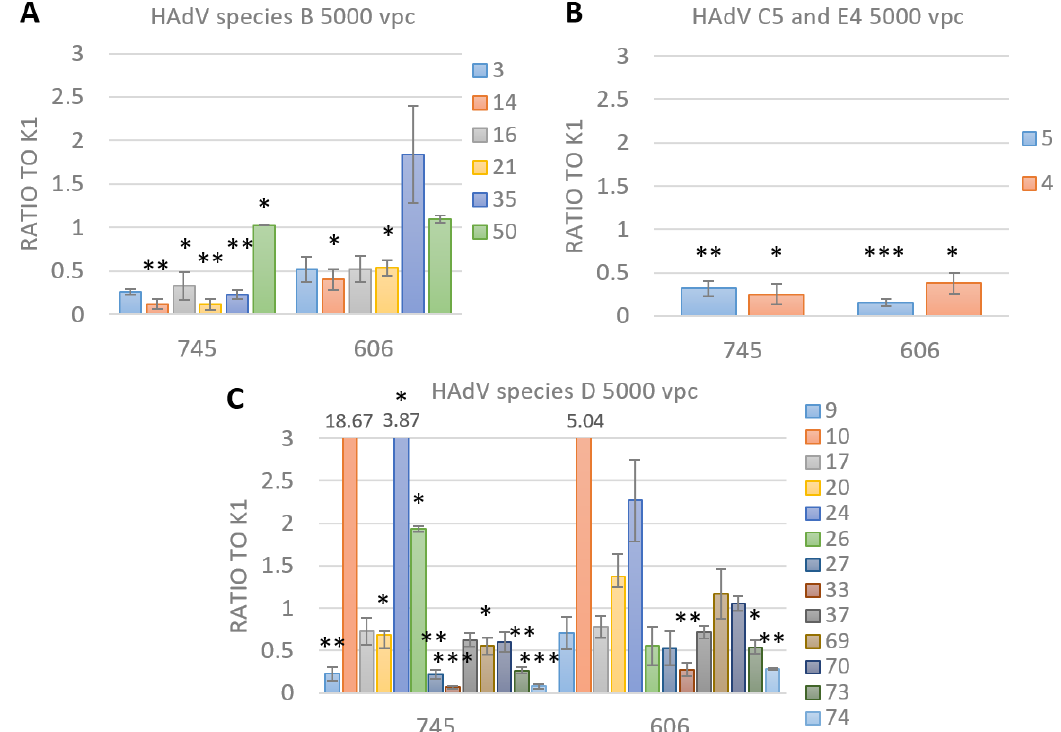
Figure 3. GLN-tagged adenovirus library screening in HSPG-depleted CHO cell lines. 24 h post-infection with 5,000 vpc luminescence was measured. All RLU (relative light units) from sulfation-ablated CHO-606 and heparan chain-ablated CHO-745 cells were normalized to the CHO-K1 cells with the wild type version of HSPG. For each Ad type, the fold increase compared to results obtained in CHO-K1 cells is displayed. A. Species B Ads show lower or similar transduction efficiency in CHO-606 and -745 cells compared with CHO-K1 cells. B. Species C and E Ads show a significant decrease in transduction efficiency compared to the wild type form of HSPG. C. For species D Ads 10 out of 13 showed a decrease in transduction efficiency in CHO-606 and -745 cells compared to CHO-K1. Mean ± SEM (standard error of the mean) of n=3 biological replicates is shown. * p ≤ 0.05, ** p ≤ 0.01, *** p ≤ 0.001. Table 2. Summary of the results from the adenovirus screening in HSPG-depleted CHO cell lines. In green are Ad types with the highest uptake detected by luciferase assay in CHO-K1 cells, in blue are Ad types with the highest uptake in -606 and in orange are Ad types with the highest uptake in -745 cells are marked. Moreover, the known receptor and adapter usage is displayed for each Ad species adapted by Arnberg et al. 2012 [36], Hensen et al. 2020 [37] and Gao et al. 2020 [38]. Adenovirus species